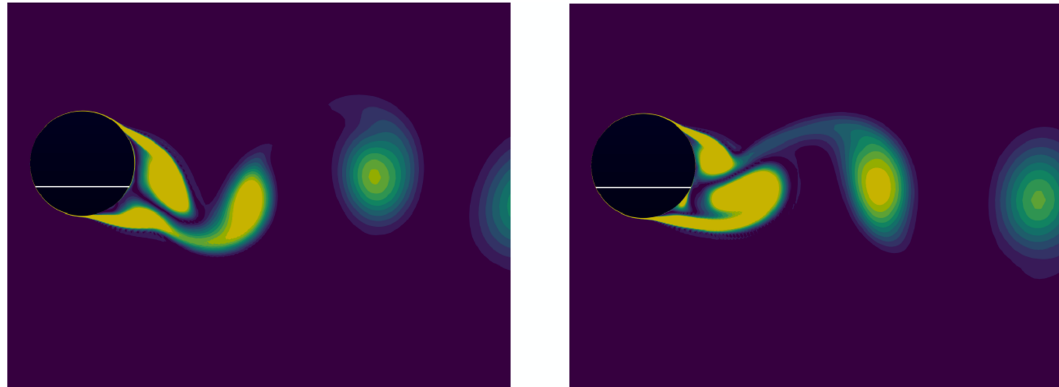
Figure 14. Instantaneous non-dimensional vorticity magnitude for U ∗ = 3 . 1 at the maximum positive displacement: t/T s = 143 . 5 (left) and t/T s = 146 . 5 (right). The vorticity is filtered to the range 0 ≤ ξD/U ∞ ≤ 5. Figures taken from Derksen